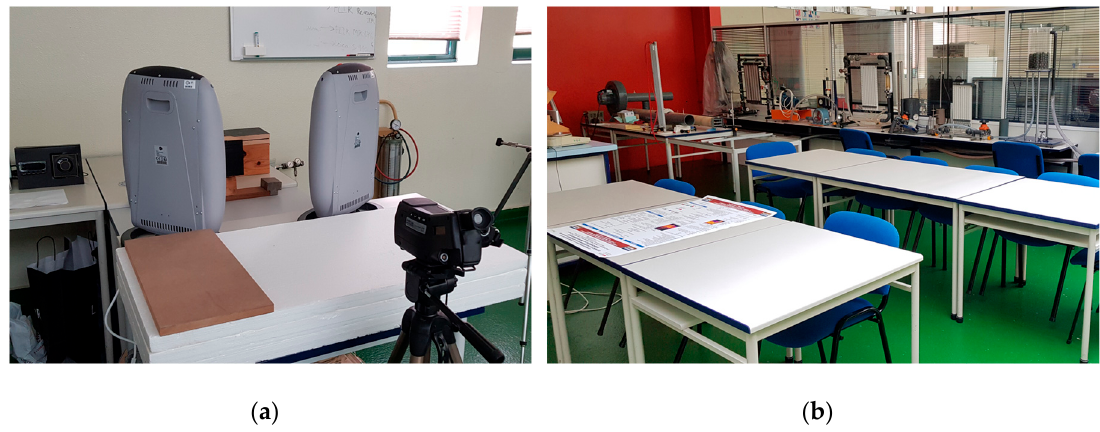
Figure 6. Laboratory layout: (a) experiments research area (e.g. thermography experiments supported by iAQ+ ); (b) classroom learning space (teaching support).